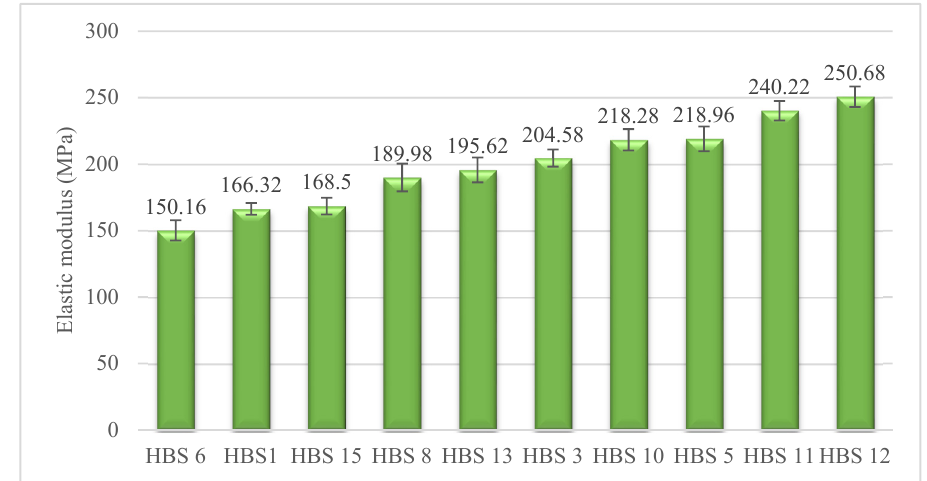
Figure 7. Average elastic modulus of hybrid braided sutures (HBSs).